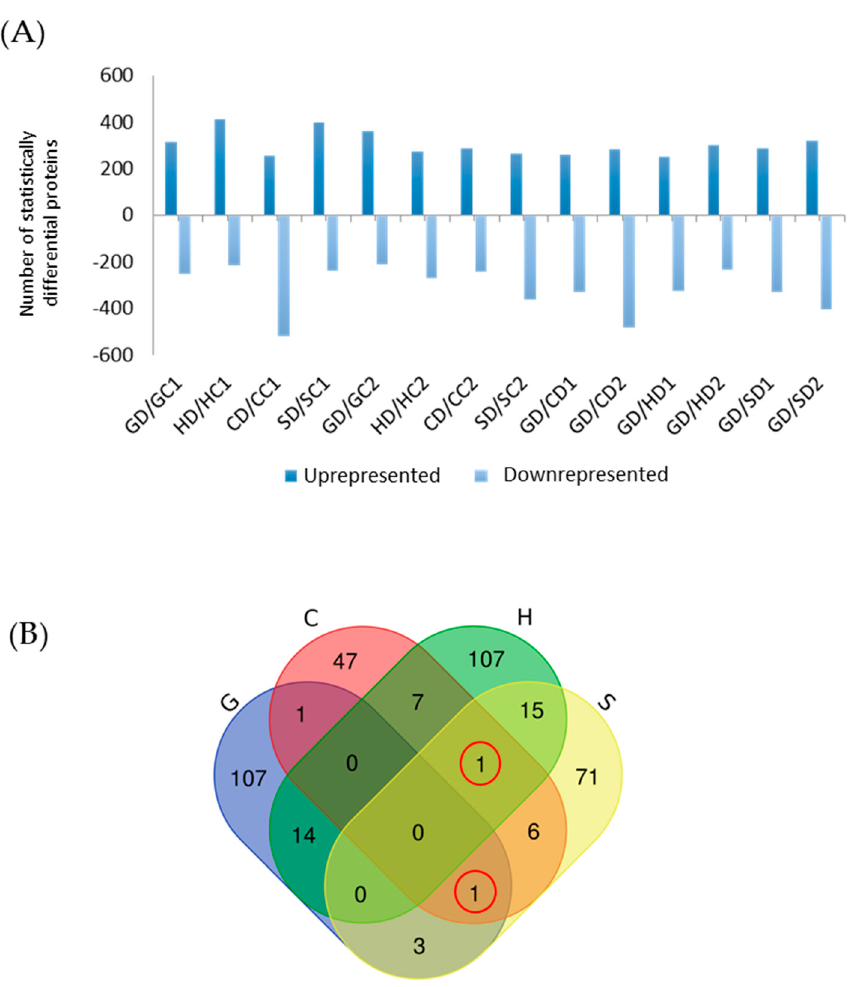
Figure 3. Variable proteins significantly (false discovery rate of 5%) uprepresented or downrepre- sented (twofold change) under drought conditions ( A ); C, Cadiz; G, Granada; H, Huelva; S, Seville. The letter following C, G, H or S denotes treatment (D, drought; C, control) and the number sampling time (1, 17 days; 2, 24 days). Venn diagram showing significantly up-represented proteins under drought conditions in each population ( B ).